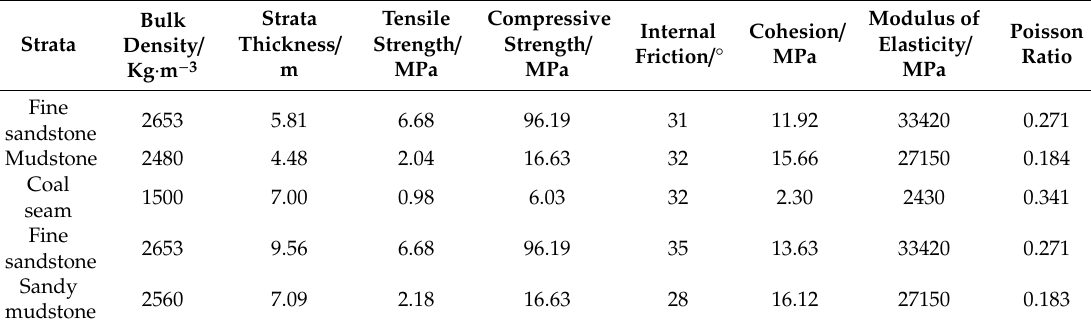
Figure 2. Bottom coal failure model in the gob-side entry.